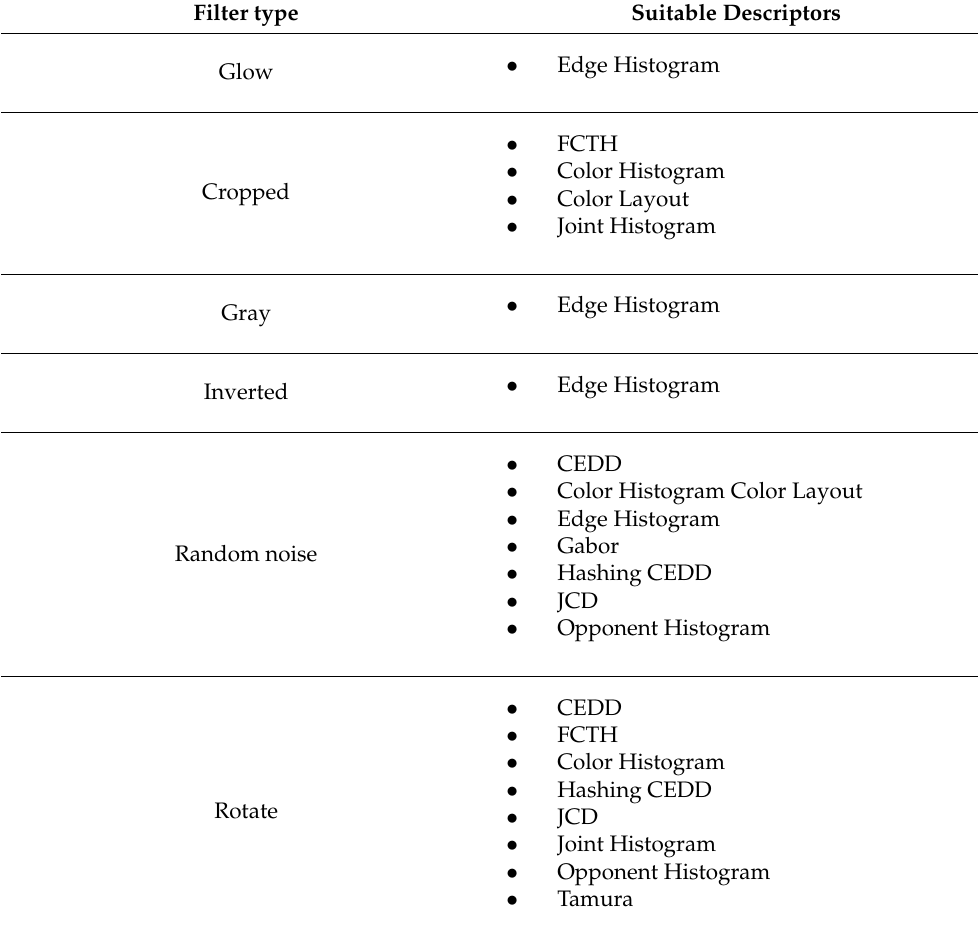
Table 9. Summary of the recommended descriptor to be used with each filtered image of human